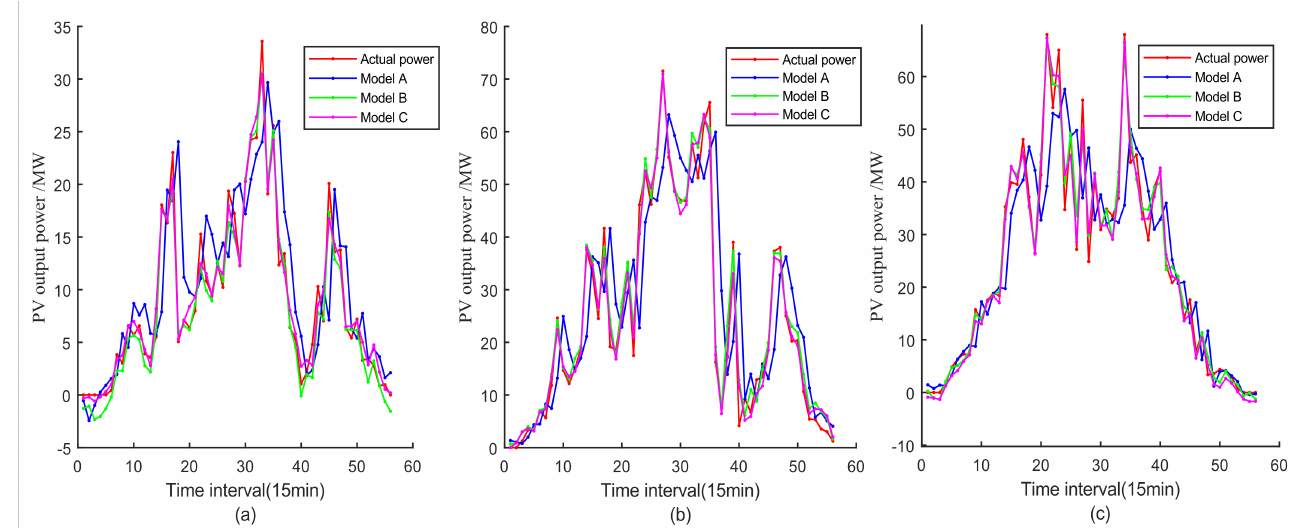
Figure 6. Forecasting results: ( a ) is the forecast result on 5 July, ( b ) is the forecast result on 7 July and ( c ) is the forecast result on 10 July.